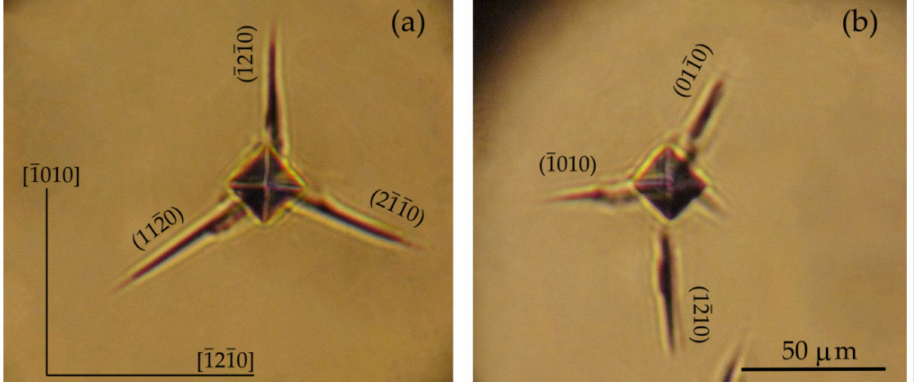
Figure 8. The Vickers indentation patterns of the (0001) plane of the CeF 3 single crystal under the load P = 100 gf. The indenter diagonals coincide with the [ 1010 ] and [ 1210 ] directions. Crystallographic (cid:8) (cid:9) (cid:8) (cid:9) 1210 ( a ) and 1010 ( b ) planes corresponding to cracks are